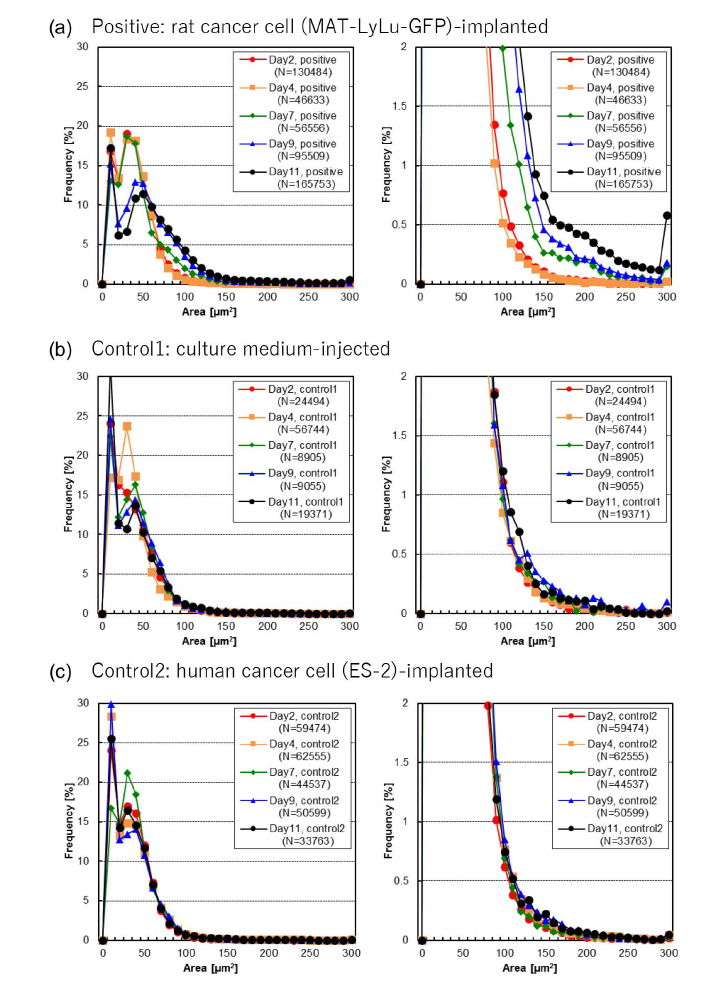
Figure 4. Size distribution of BF cell areas in positive ( a ), control 1 ( b ), and control 2 ( c ) blood. Each size distribution map indicates 2, 4, 7, 9, or 11 days after the implantation of rat cancer cells ( a , positive), culture medium ( b , control 1), or human cancer cells ( c , control 2). Measurements were performed for six rats for positive cases and three for controls. The size distribution maps on the right are magnified versions of those on the left, to emphasize the detailed findings for large cells. Here, N represents the total number of cells in each size distribution